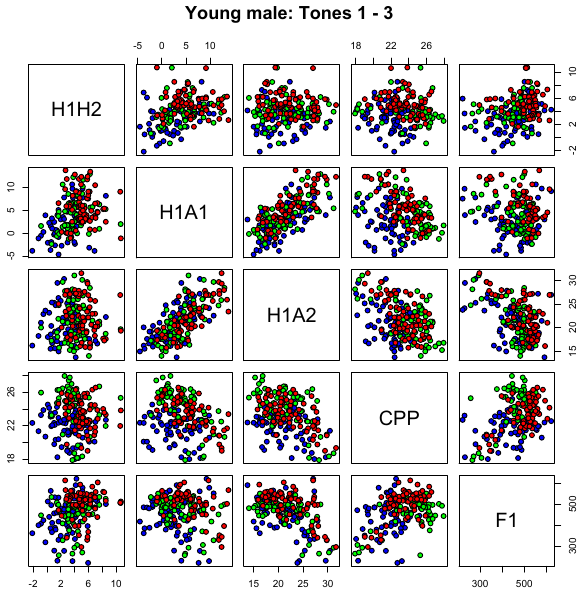
Figure 5 : Scatterplot matrices with five acoustic measures of breathiness for young males: blue for T1, green for T2, and red for